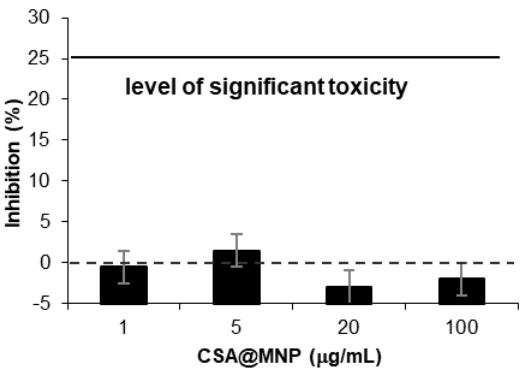
Figure 8. Cytotoxicity experiments: growth inhibition capacity of CSA@MNP (at 0.2 mmol/g CSA-loading) on A431 cell line.